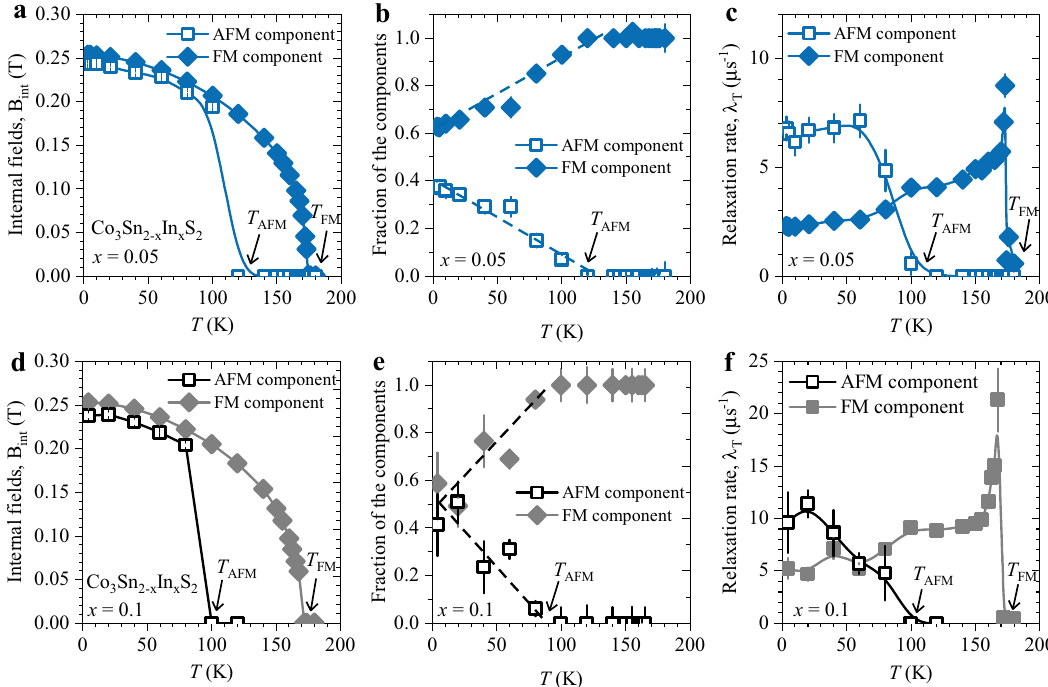
Fig. 3 (Color online) The temperature dependence of various fi t parameters of the μ SR experiments. The temperature dependences of the internal magnetic fi elds ( a , d ), the relative volume fractions ( b , e ) and the transverse relaxation rates ( c , f ) of the two magnetically ordered regions in the samples x = 0.05 and 0.1. The error bars represent the s.d. of the fi t parameters. Arrows mark the critical temperatures T AFM and T FM for AFM and FM